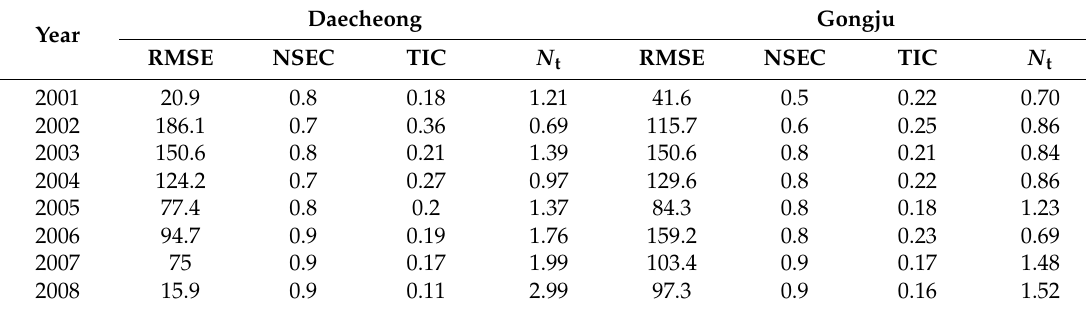
Table 2. Annual bias and RMSE of the control